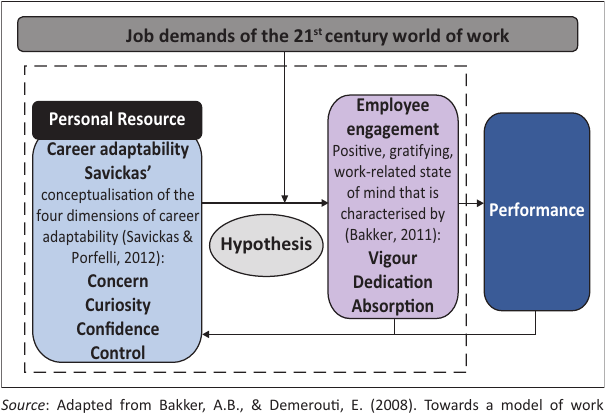
FIGURE 1: Theoretical relationship between career adaptability and employee engagement.